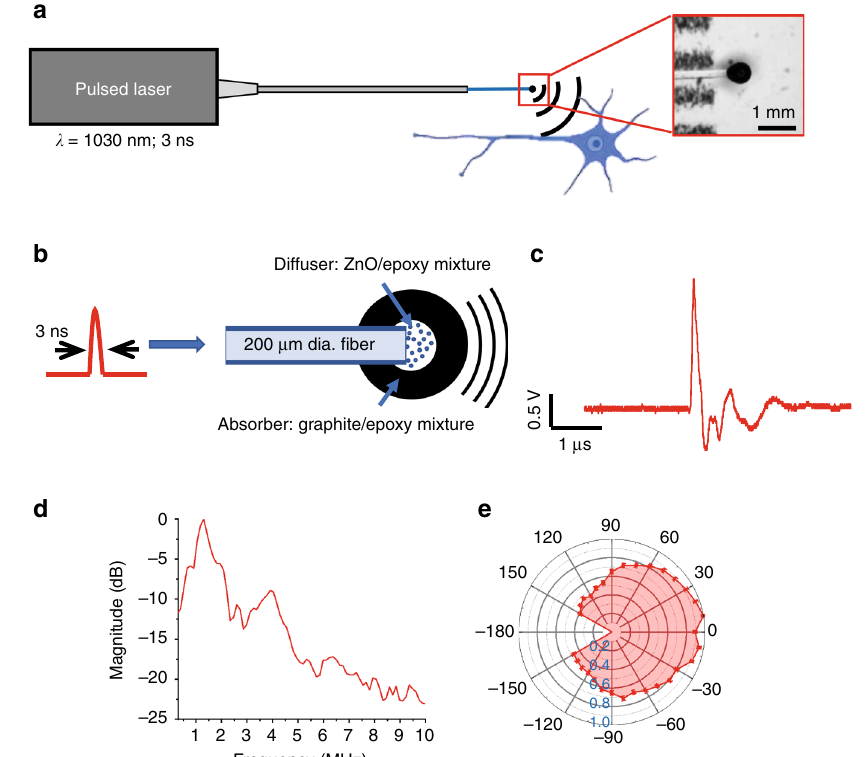
Fig. 1 Design of FOC and characterization of the FOC-generated acoustic wave. a The concept of optoacoustic neuromodulation through a FOC. Insert is an enlarged FOC tip under a stereoscope. b Schematic of acoustic wave generation. c Representative acoustic wave recorded with a transducer. d , e radiofrequency spectrum and angler intensity distribution of FOC-generated acoustic wave. Error bar: ± SD (1 fi ber, 3 repeats) Source data are provided as a Source Data fi le.